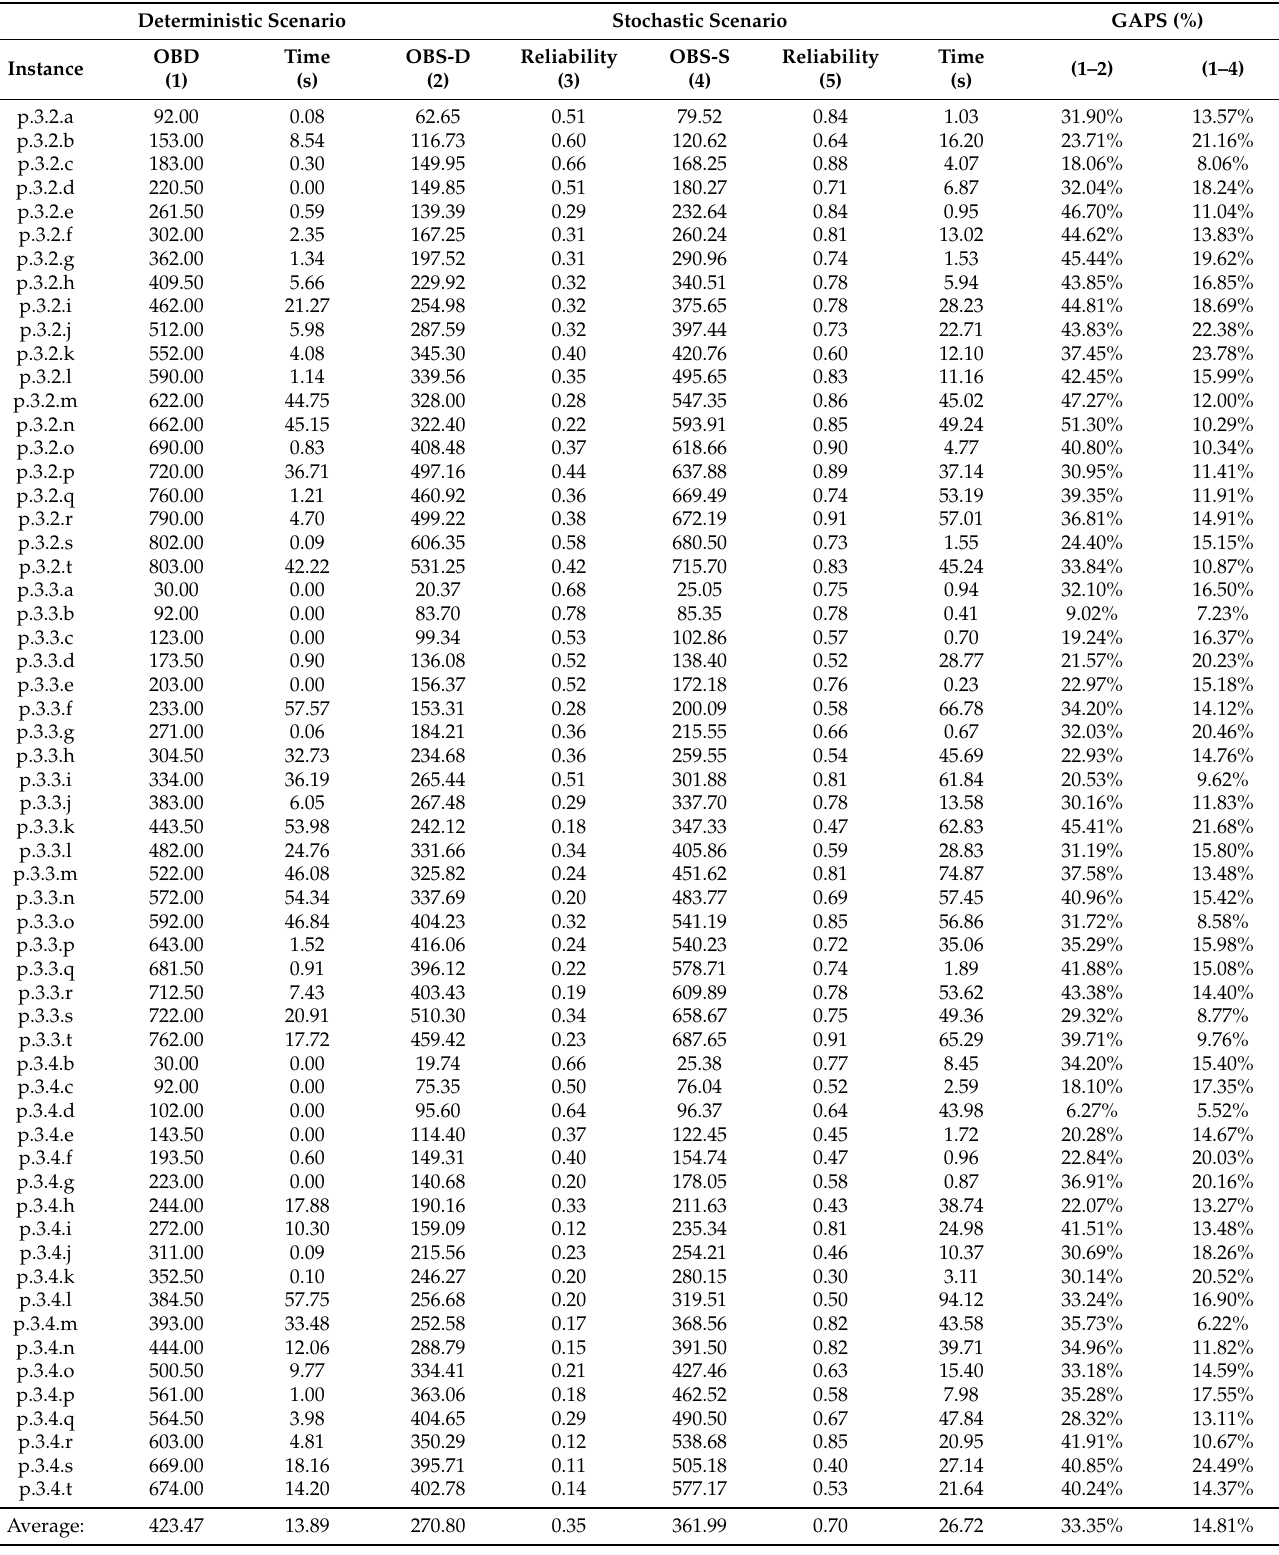
Table 8. Results for p 3 instances in a stochastic scenario with a high variance ( c =